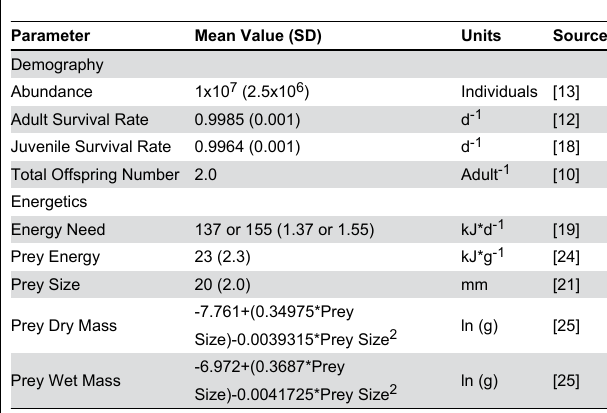
Table 1. Parameters used in a model to estimate abundance and energy consumption of Purple